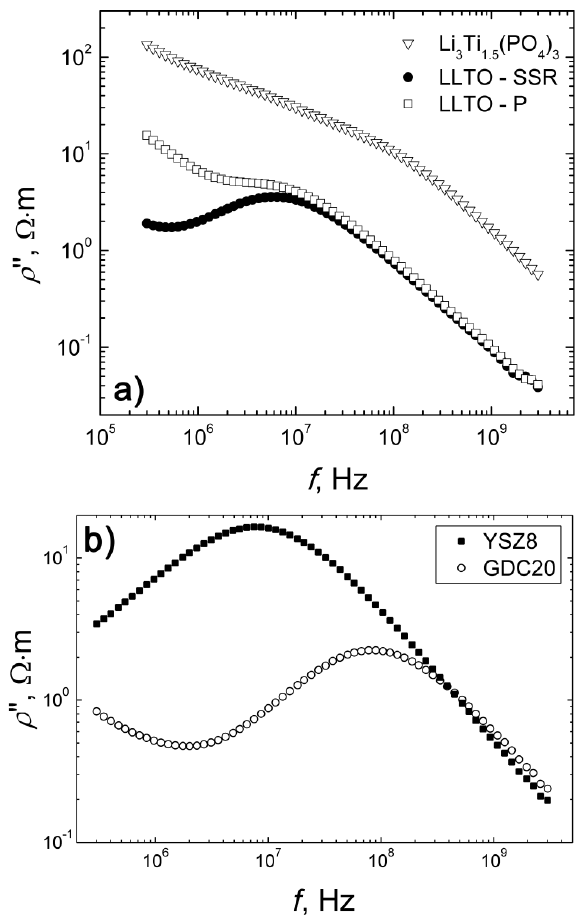
Figure 5: Frequency dependences of imaginary part of impedance of Li + -conducting ceramics at 300 K (a) and -conducting ceramics at 700 K (b).